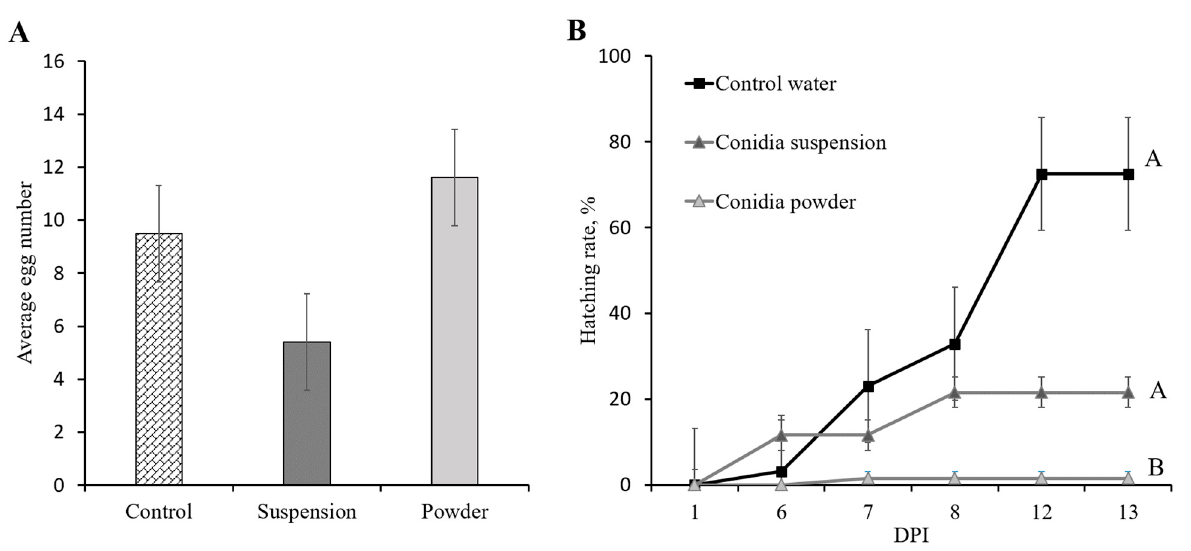
Figure 7. Assessment of Mb7-GFP’s effect on Rhynchophorus ferrugineus eggs per female and egg hatching rate by microcosms assay. ( A ) Average number of eggs per female in non-treated control and following Mb7-GFP conidia treatment as conidia suspension (10 8 conidia mL − 1 ) and conidia powder (5 × 10 8 conidia total). ( B ) Average hatching rate of eggs in the control group and following Mb7-GFP conidia treatment as conidia suspension and conidia powder. Curve followed by different letter differ significantly. Univariate analysis of hatching rate by days PI (Repeated measures)—Treatment p = 0.0022; Day PI p < 0.0001; Treatment × Day p < 0.001. PI = Post-Inoculation.